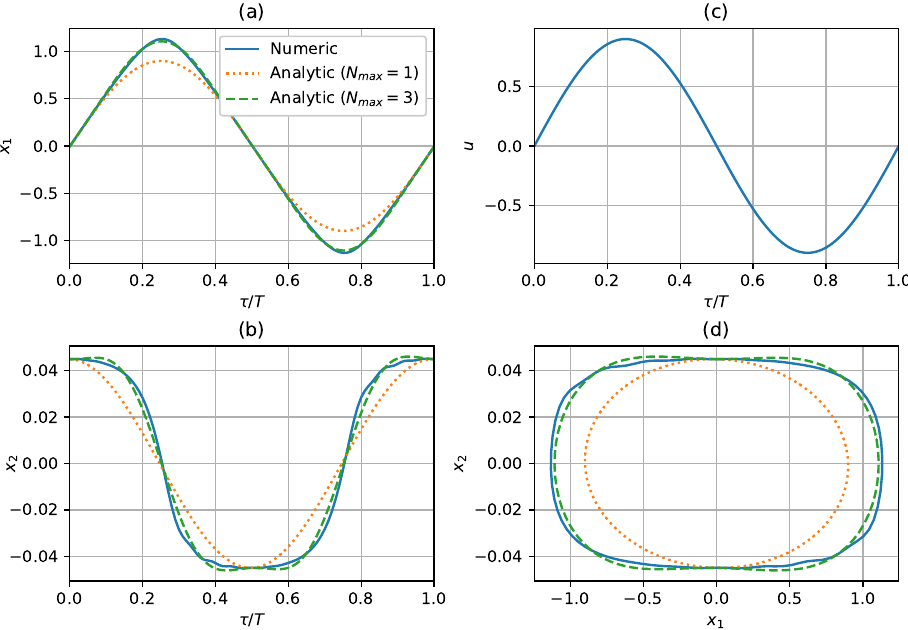
Figure 3. Comparison of the pendulum behavior predictions using numerical and analytical solu- tions (69) ( N max = 1,3) for η = 0.1428, ω = 0.05, A = 0.9 and φ = 0 ( T = 2 π / ω ). ( a ) x 1 vs. τ / T , ( b ) x 2 vs. τ / T , ( c ) Input u vs. τ / T , and ( d ) phase plane ( x 1 , x 2 )